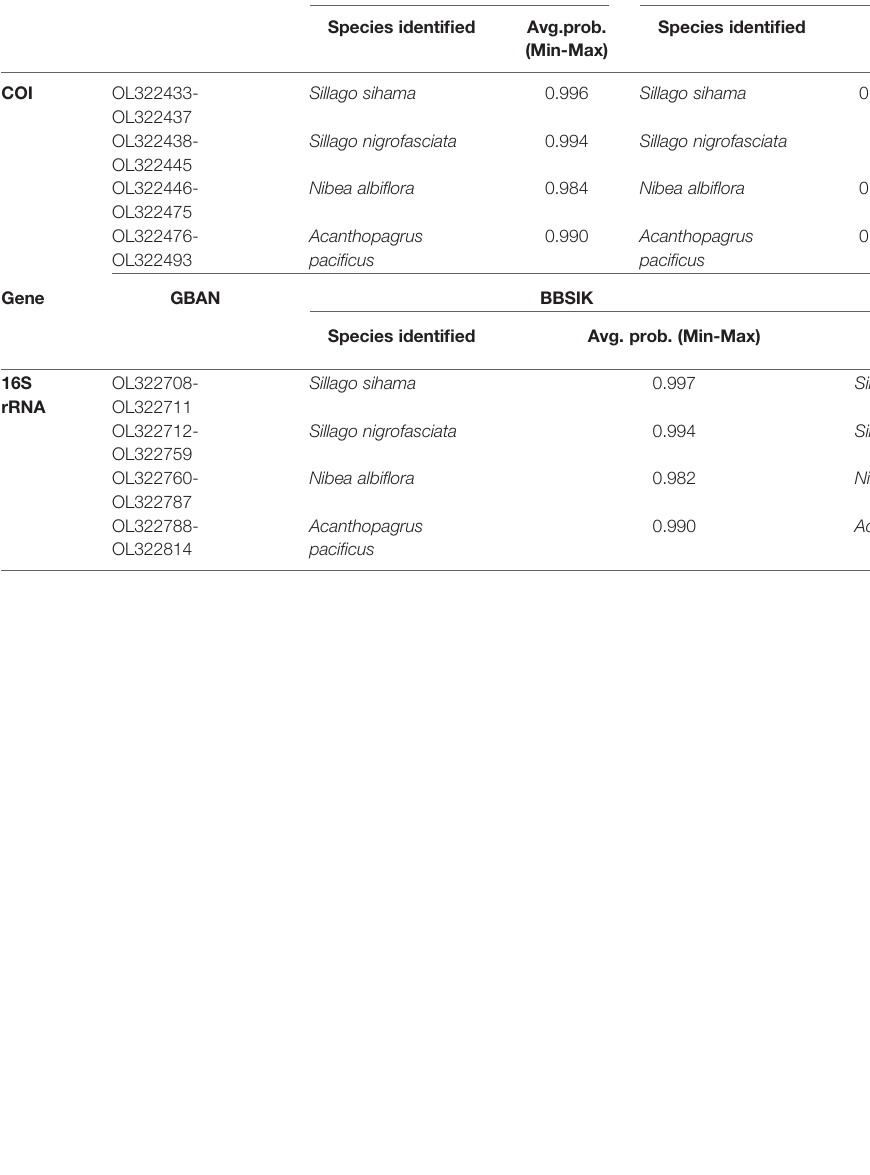
TABLE 1 | Species identi fi cation through BarcodingR package with the assignment probabilities (average, minimum and maxium).